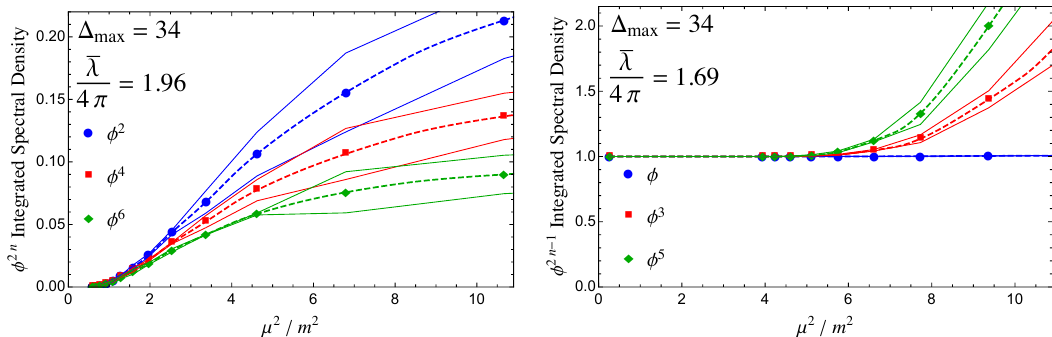
Figure 9 . Integrated spectral densities for (cid:30) 2 , (cid:30) 4 , and (cid:30) 6 at (cid:22) (cid:21) at (cid:22) (cid:21) = 1 : 69 (right), both with (cid:1) max = 34. The spectral densities in each plot have been rescaled 4 (cid:25) by an overall coe(cid:14)cient such that the (cid:12)rst data points match. The thin lines indicate the magnitude of the di(cid:11)erence between these results and those at (cid:1) max = 30, providing a rough estimate of the convergence. In both plots, all three curves converge to the same universal behavior in the IR.